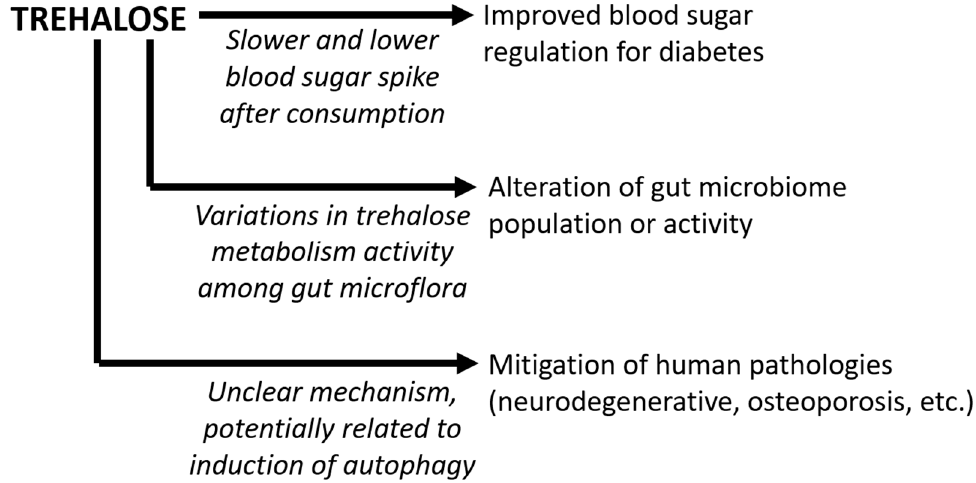
Figure 2. Bioactive roles of trehalose as a dietary nutrient. The three main bioactive roles of trehalose discussed in this manuscript are indicated, along with arrows to indicate the proposed mechanisms of action (text in italics).